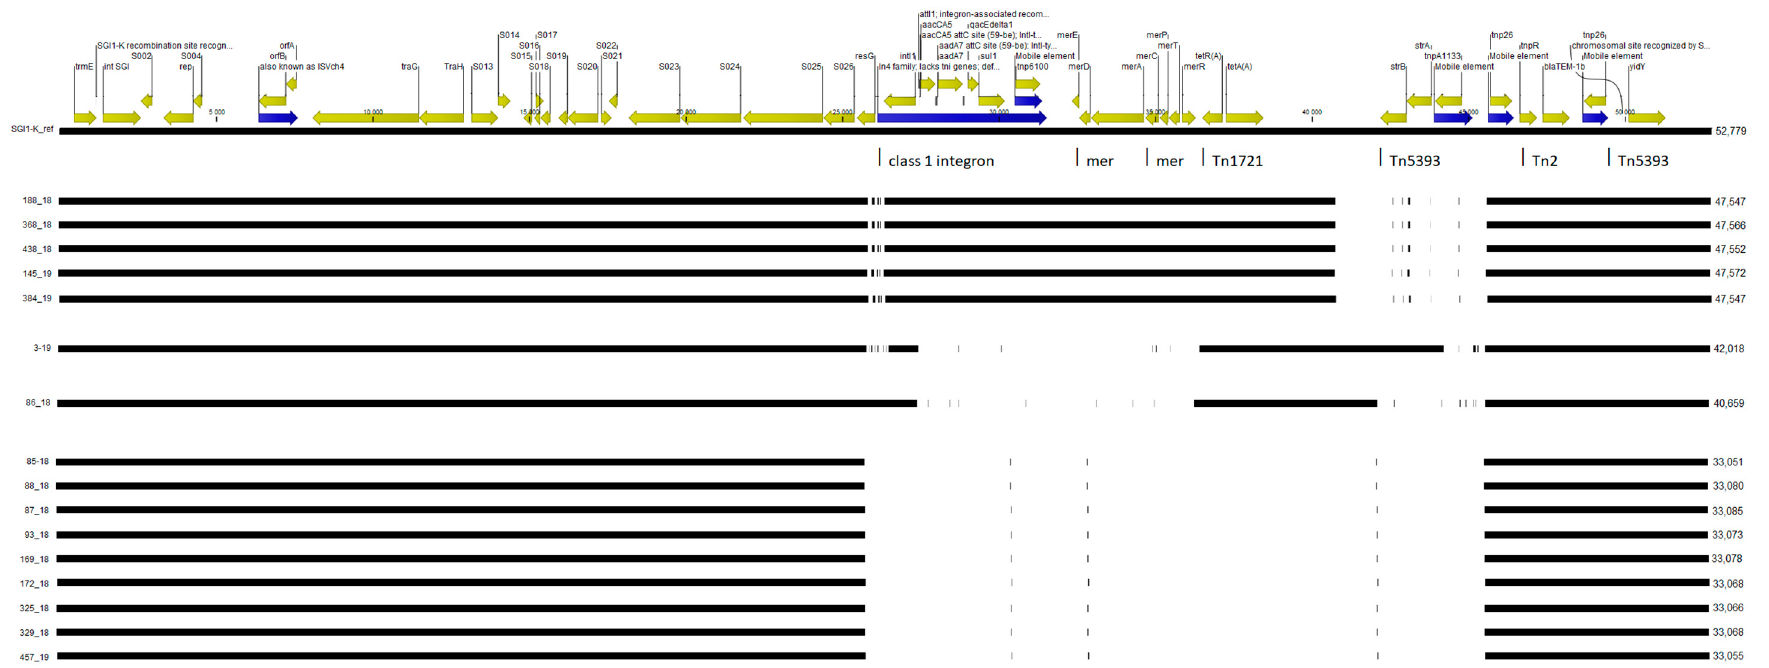
Figure 2. The graphical alignment of SGI1-K sequences with SGI1-K from the SRC73 strain (shown as a reference). A lack of black line means deletion of a given region of the island. Four different patterns of this locus can be distinguished, with a different pattern for mobile element deletions.